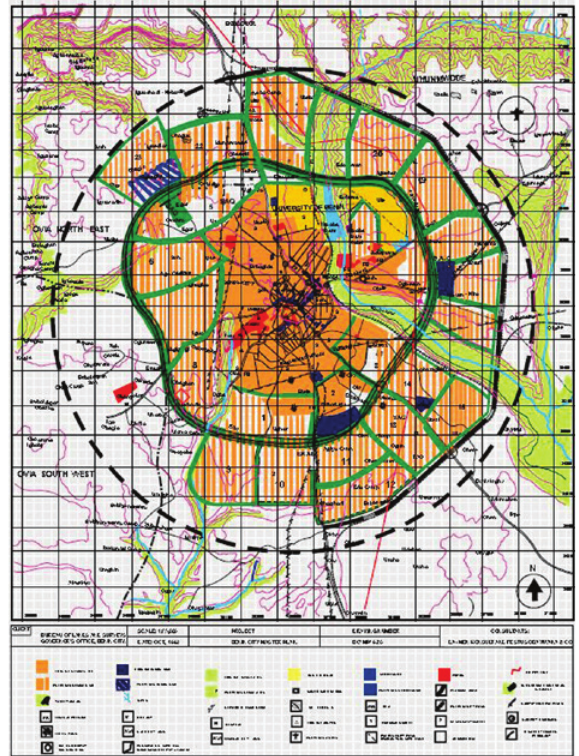
Fig. 1. Plan of Benin-city showing the existing form Source: Abakare